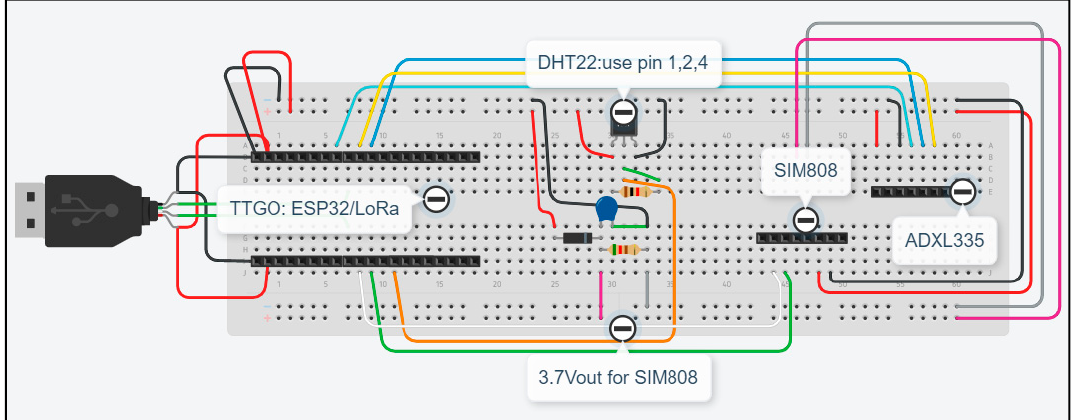
Figure 5. Prototype connection scheme.